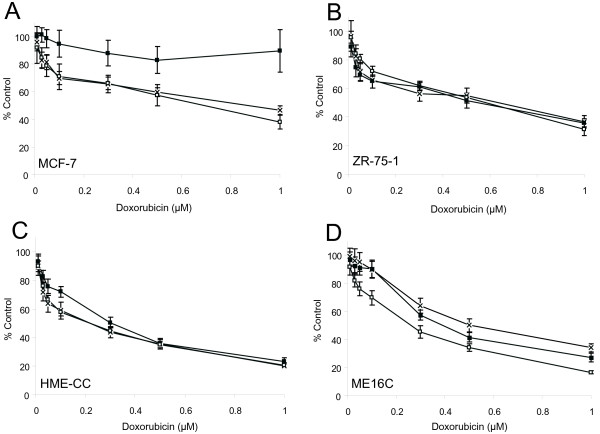
Chemosensitivity is altered in the MCF-7 cell line following transduction with p53-RNAi. ME16C, HME-CC, and ZR-75-1 cell lines had similar chemosensitivity curves for wildtype (x), p53-targeted RNAi expressing cells (solid square) and p53 mismatch RNAi expressing cells (open square). Only the p53-RNAi MCF-7 cells showed significant chemoresistance.